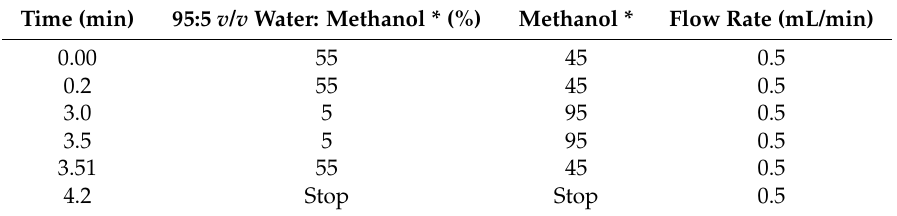
Table 1. LC-MS/MS Gradient Conditions for CRV431